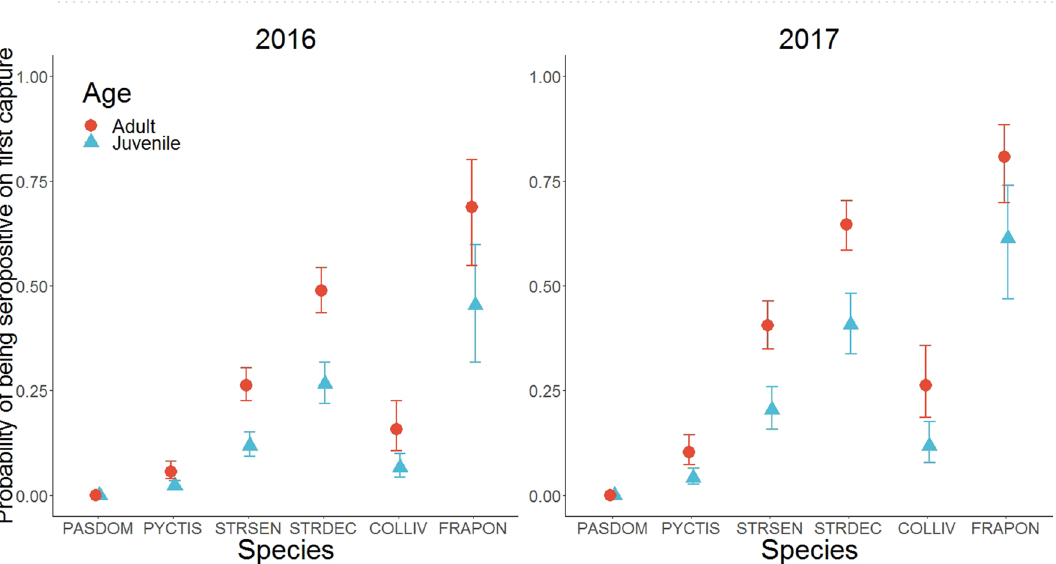
Figure 5. Probabilities of being seropositive on first capture for each bird species according to the age of the individuals and the year of sampling. PASDOM stands for Passer domesticus , PYCTIS for Pycnonotus leucotis , STRSEN for Spilopelia senegalensis , STRDEC for Streptopelia decaocto , COLLIV for Columba livia and FRAPON for Francolinus pondicerianus. Error bars represent 95% confidence